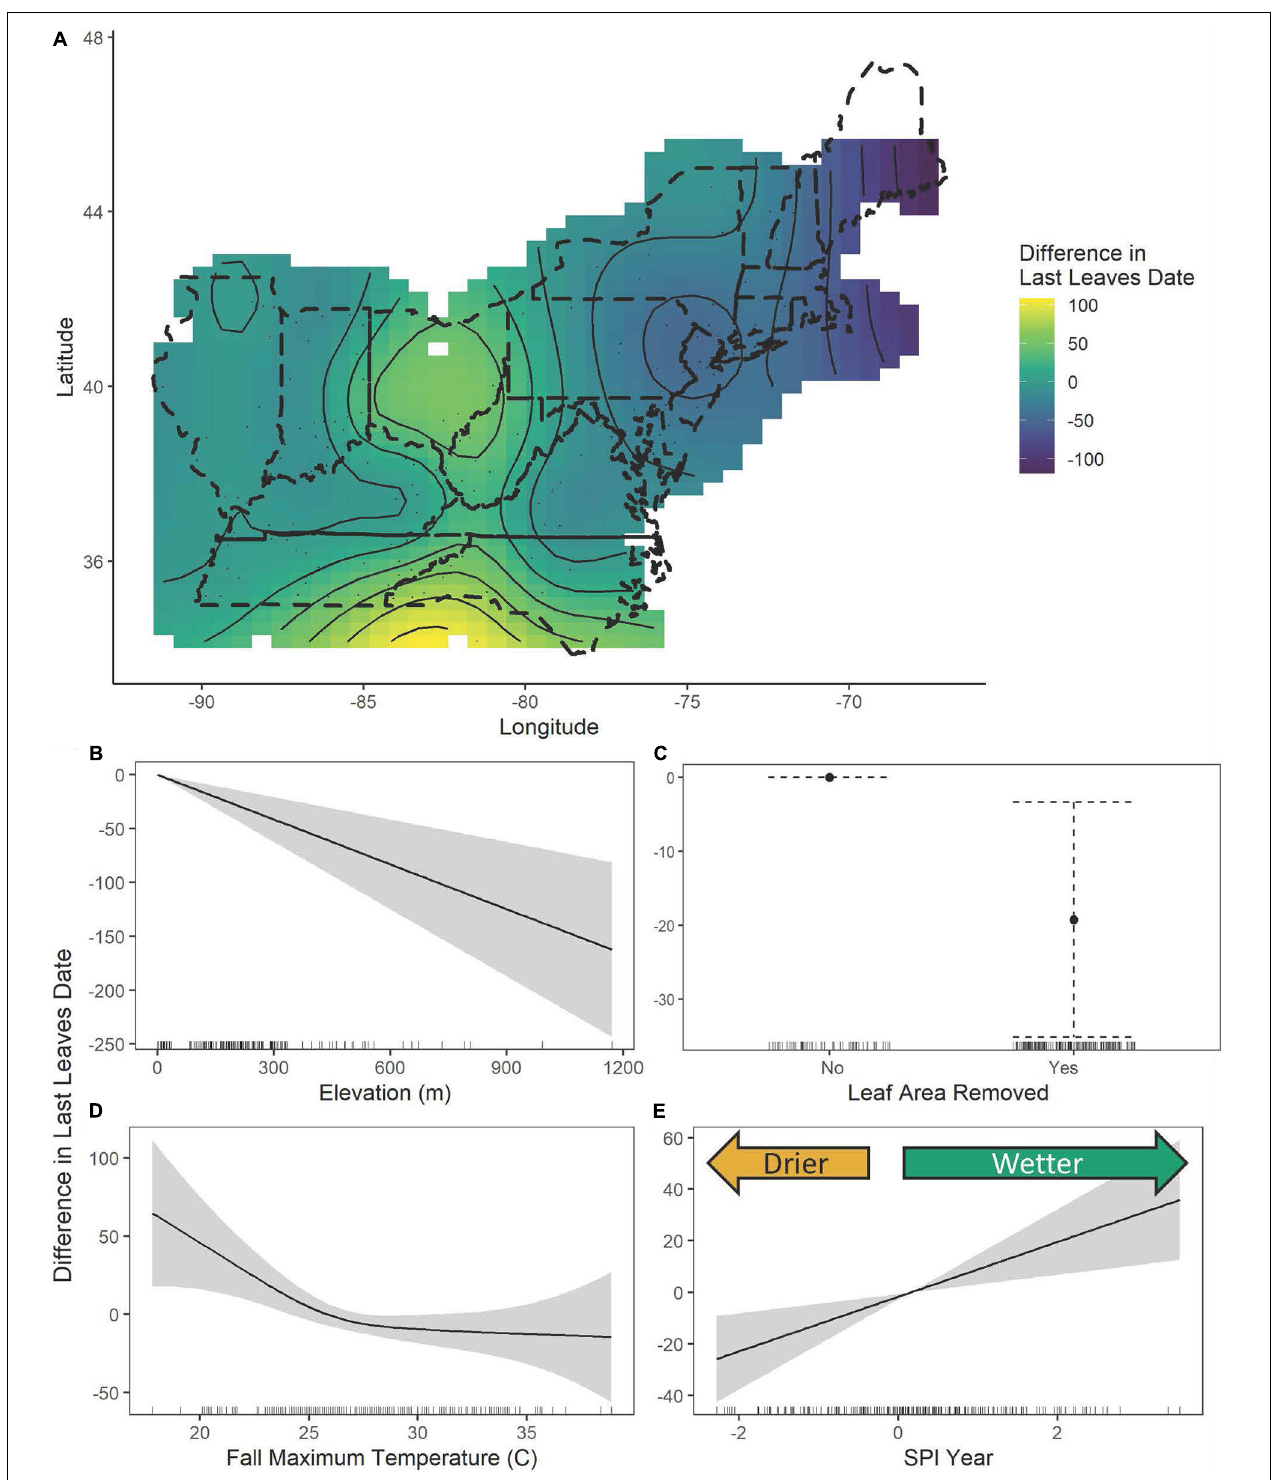
FIGURE 4 | The estimated contributions of latitude and longitude (A) , elevation (B) , leaf area removed (C) , maximum fall temperatures (D) , and the SPI of the year of collection (E) from the general additive model of the last date with preserved leaves. In figure (A) , the dashed lines show the United States state boundaries in the included regions, while the solid lines show the fitted smoothed curves output from the GAMs overlaid with the fitted contour showing spatial differences in last leaf dates. In figures (B,D,E) the solid curve while the gray regions or dotted whiskers represent the 95% confidence interval and in figure (C) the solid point shows the estimated contribution while the dotted lines show the 95% confidence interval. Tick marks along the x-axis indicate the density of specimens.